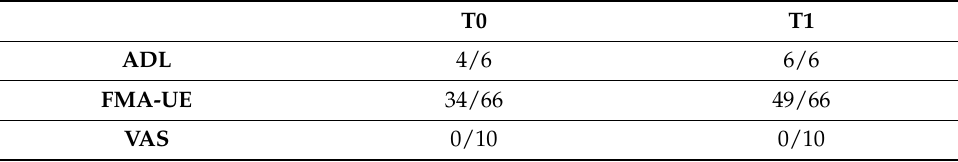
Table 1. Results of outcome